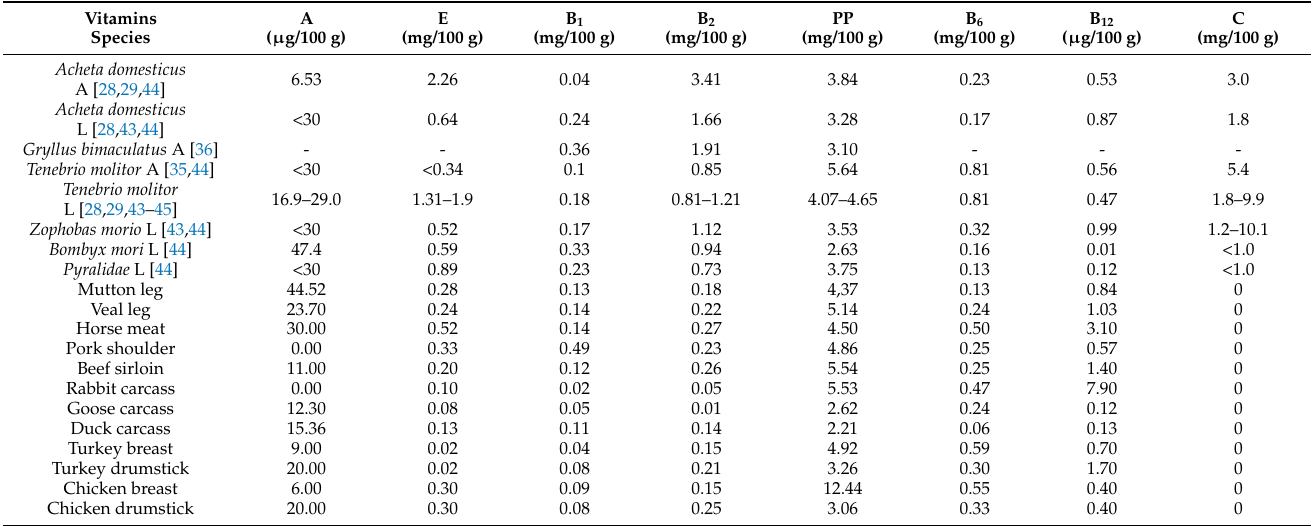
Table 9 indicates the value of nutritional quality indicators for vitamins in selected insect species and meats. In insects, regardless of species and form of development, the content of most vitamins (retinol, thiamine (except in the adult insects of the species Acheta domesticus ), riboflavin, niacin, and pyridoxine) was well-balanced to energy (Table 9). INQ ratios exceed the value of